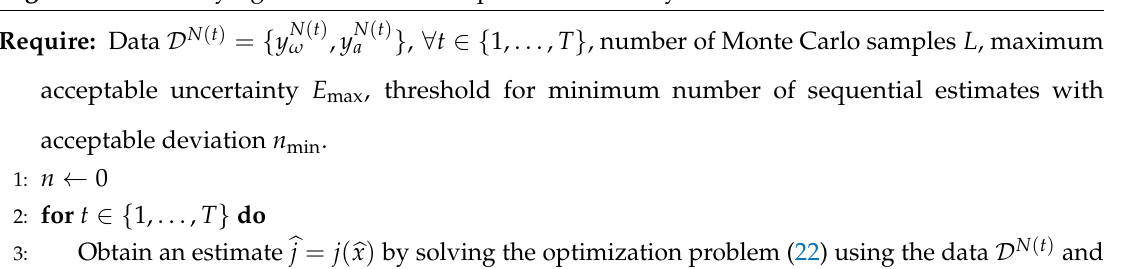
Algorithm 4 Identifying an estimate of acceptable